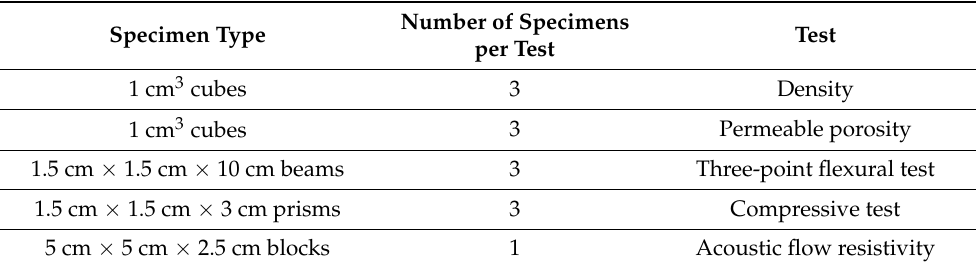
Table 4. Test samples for materials characterization.